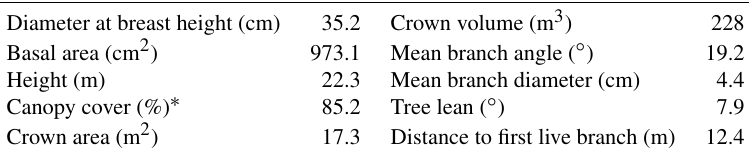
Table 1. Biometric characteristics of the monitored tree (adapted from Cayuela et al., 2018b).